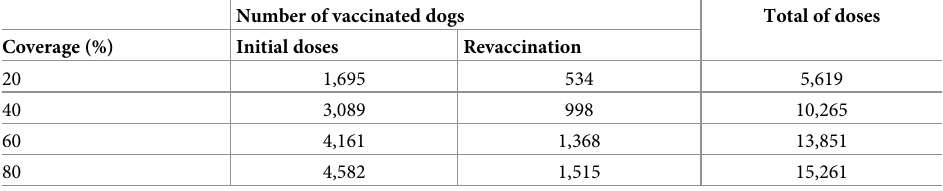
Table 2. Vaccinated dogs according to year and applied doses in a population of 3,000 animals. Number of vaccinated